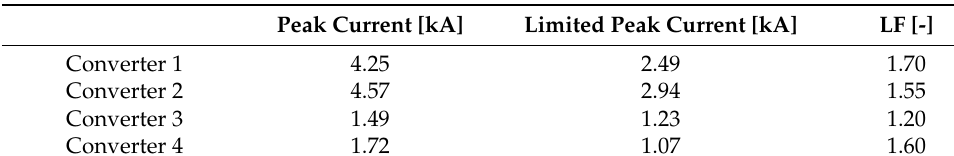
Figure 23. Converter fault currents with and without current limiter under pole-t- ground fault condition. Table 6. Peak current and limiting factor comparison for pole-to-ground fault.